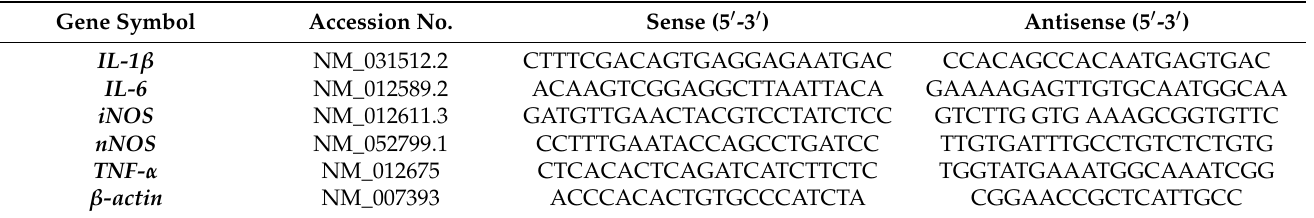
Table 3. Oligonucleotides sequences used for reverse transcription-polymerase chain reaction assays. Gene Symbol Accession